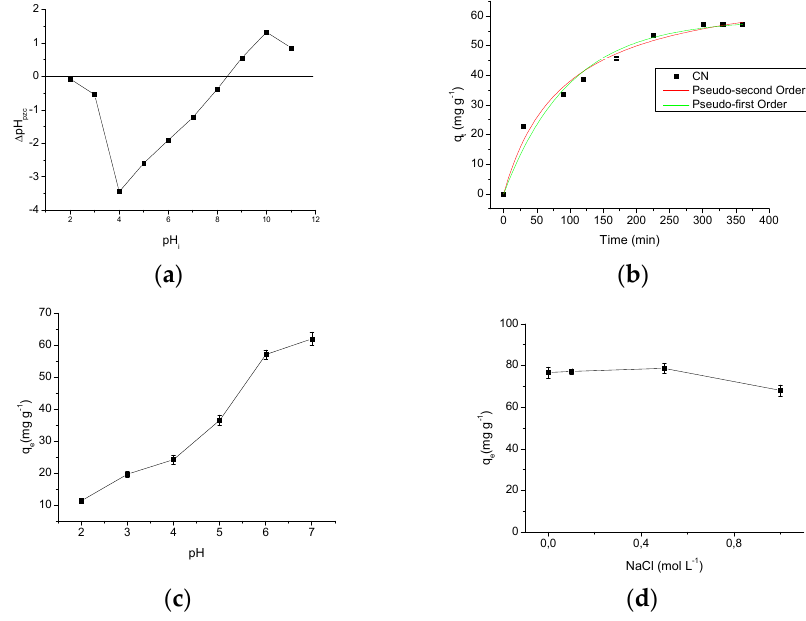
Figure 7. ( a ) Figure of the point of zero charge from the CN polymer; ( b ) contact time effect in the AMI adsorption by CN polymer and the theoretical kinetic models; ( c ) effect of pH in the AMI adsorption by CN polymer; ( d ) effect of NaCl concentration in the AMI adsorption by CN polymer.